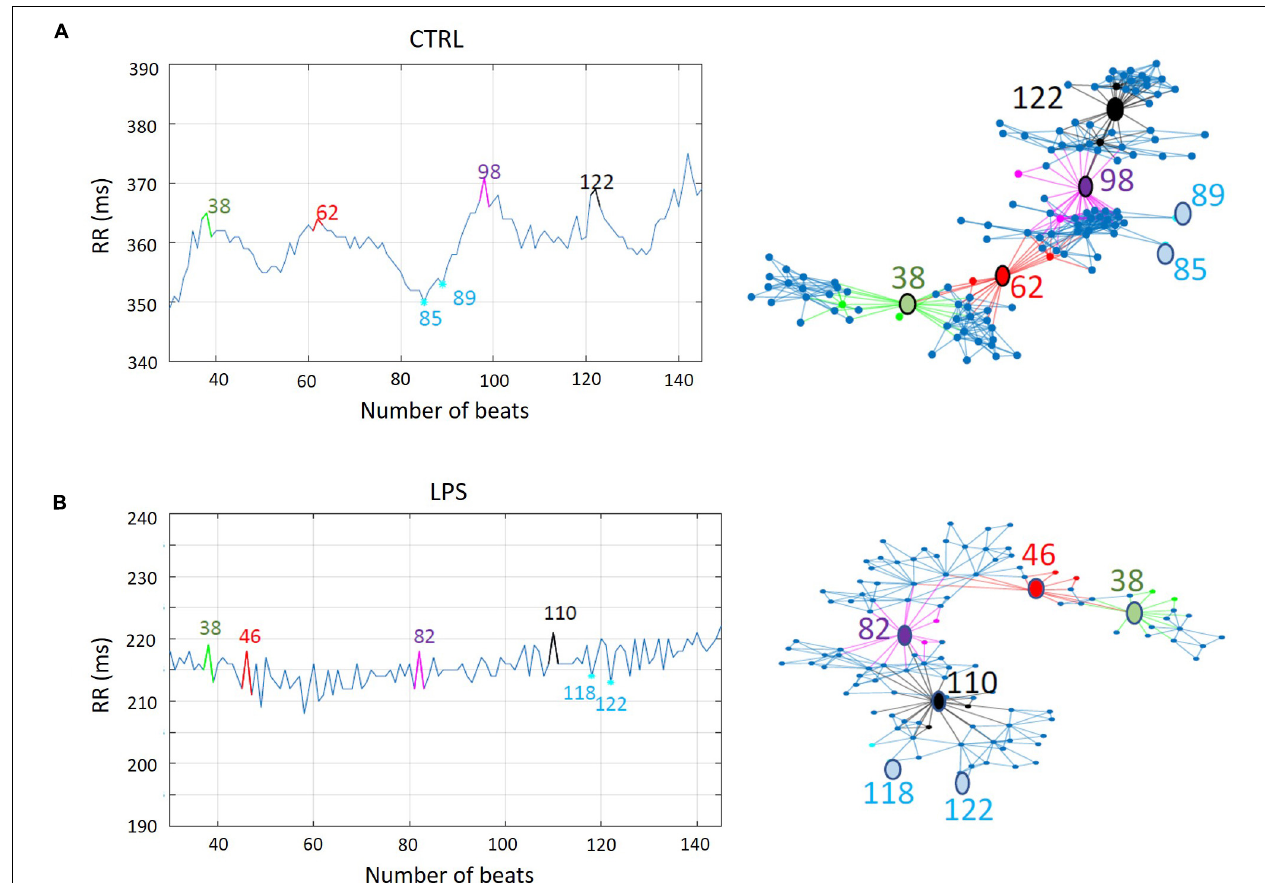
FIGURE 5 | Impact of lipopolysaccharide injection on network representation of vertical visibility analysis of RR time series in one lamb. (A) The evolution of a RR time series (left) and the corresponding dimensionless network representation of the vertical visibility graph analysis computed with a horizon of 30 points (right). Some noteworthy nodes are annotated. For example, nodes 85 and 89, which are minima of the RR time series, have very few connections with the other nodes. Other nodes on the outer side are also minima. On the contrary, nodes 38, 62, 98, and 122–respectively in green, red, magenta, and black–are examples of maxima of the RR time series. The links (edges) in the same color show the multiple connections they have with the nearest neighbors. These maxima-related nodes are separated by subnetworks of highly connected nodes (in blue), whose size is related to the horizon distance. Note the overall high density of the links between nodes, which reflects the high cardiac variability in control condition. (B) A similar illustration following lipopolysaccharide injection in the same lamb. Similar to (A) , nodes 118 and 122—examples of minima of the RR time series—have very few connections with the other nodes. Contrary to (A) (representing the control condition), nodes 38, 46, 82, and 110—examples of maxima of the time series—are much less distinct nodes of the network. In addition, the subnetworks between these maxima-related nodes are barely identifiable, due to the fewer connections compared to the control condition. Such decreased connectivity attests to the low heart-rate variability, indicating an abnormal and inadequate adaptation of the autonomic nervous system. Of note, the orientation of the network representations has no particular meaning; it was only chosen to facilitate network